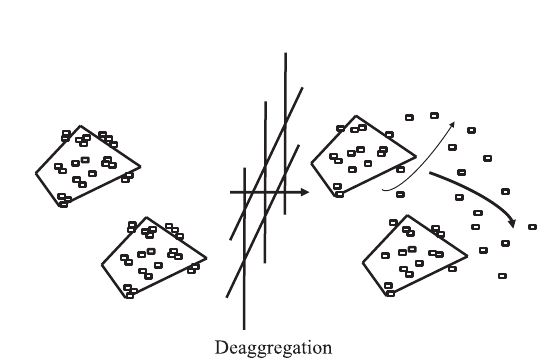
Fig. 6 Schematic of small drug particles at the surface of large lactose carrier particles some in the form of aggregates depicting their liberation initially as a deaggregation phenomenon in response to